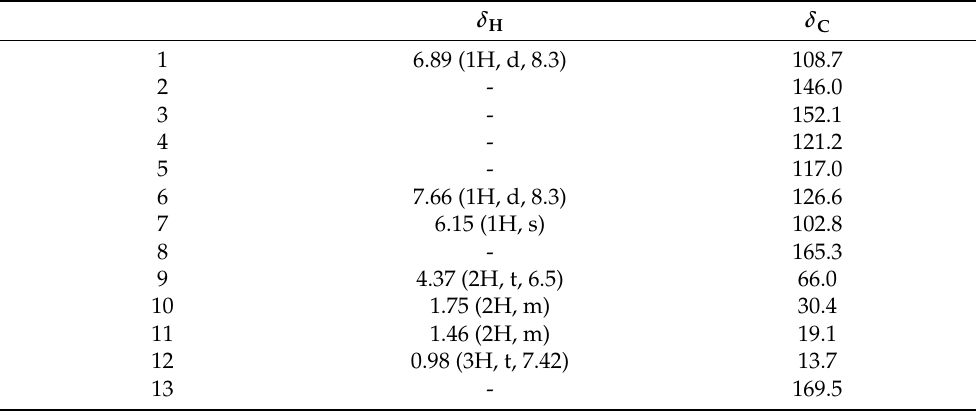
Table 1. 1 H and 13 C-NMR data of compound 1 in CDCl 3 -d ( δ in ppm, J in